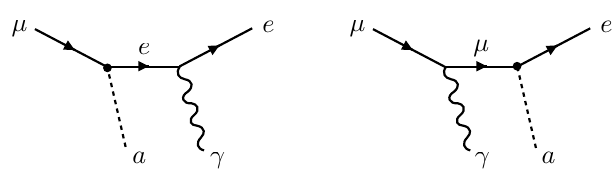
Figure 38 . Diagrams contributing to µ → eaγ